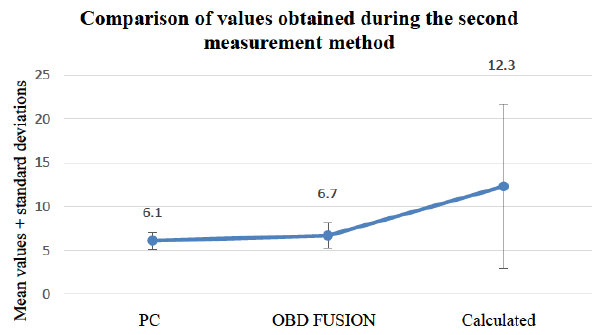
Figure 4: Comparison of values obtained during the second mea- surement method